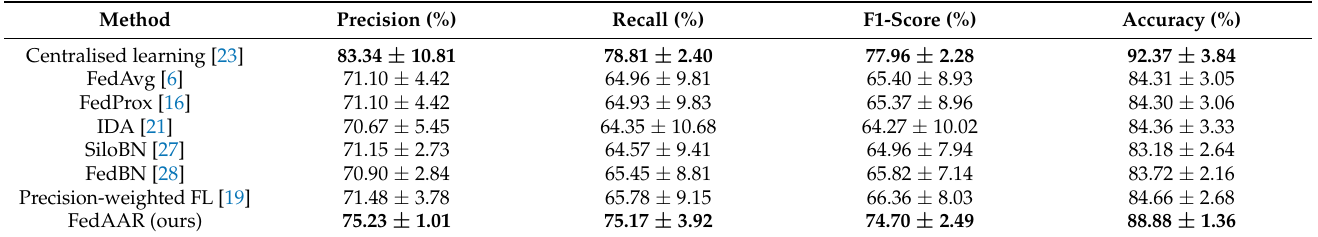
Table 2. Comparative results (mean ± std) of our proposed FedAAR with state-of-the-art federated learning (FL) methods. The best two results for each metric are highlighted in bold. Method